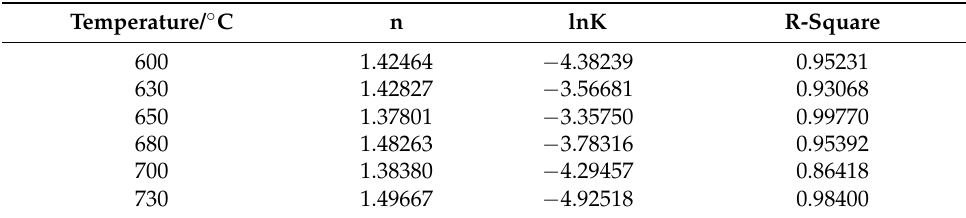
Table 5. n and lnK values obtained from linear fitting.